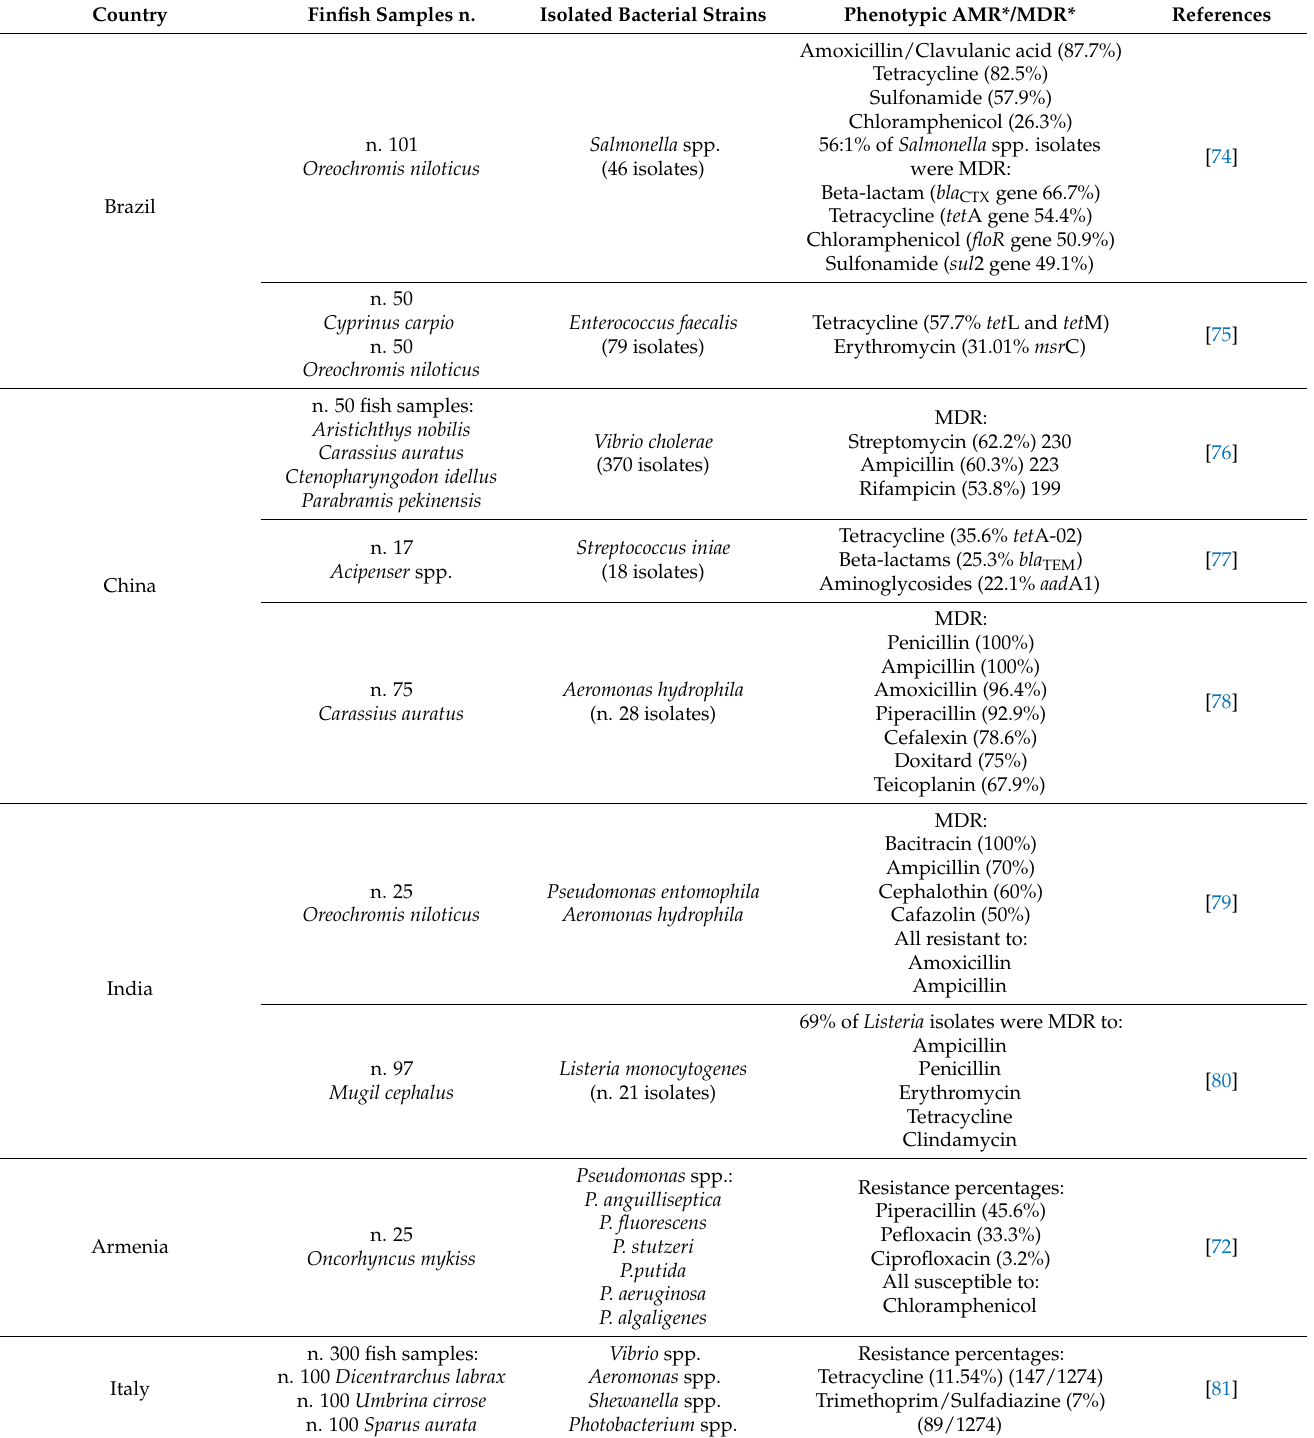
Table 4. AMR* and MDR* of bacterial strains isolated from aquaculture finfish sample